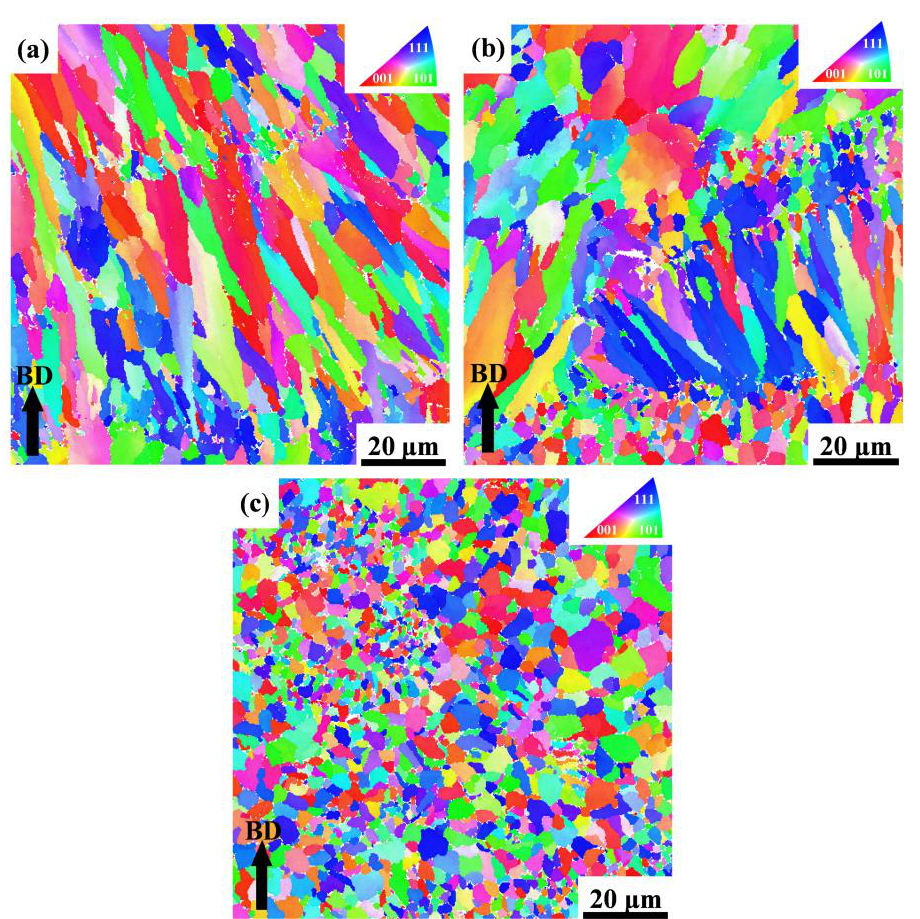
Figure 8. EBSD orientation maps of the Al grains across their building direction in ( a ) S0, ( b ) S4, and ( c ) S1. The IPF color code represents the grain orientation.